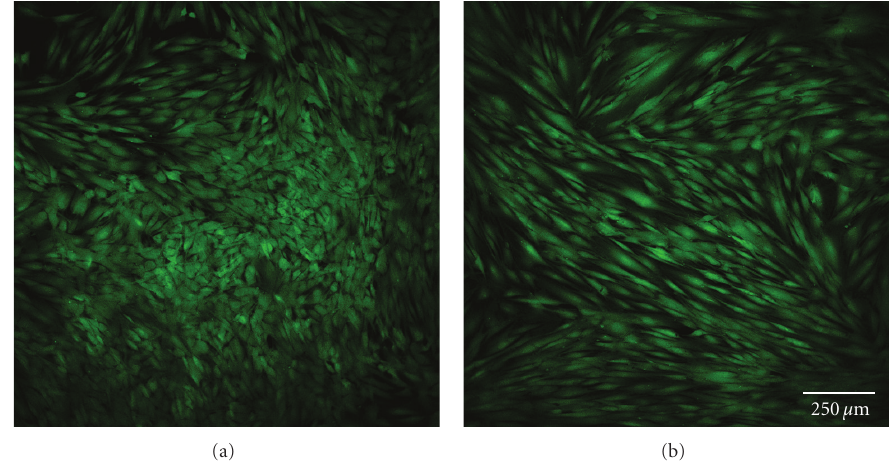
Figure 3: Fibroblast cells cultured on glass discs coated with nonhexylated polymer after 24 h (a) and 72 h (b).